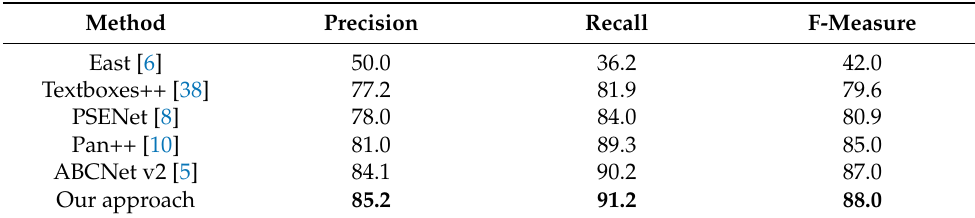
Table 2. Detection comparison with state-of-the-art methods on the Total-Text dataset.